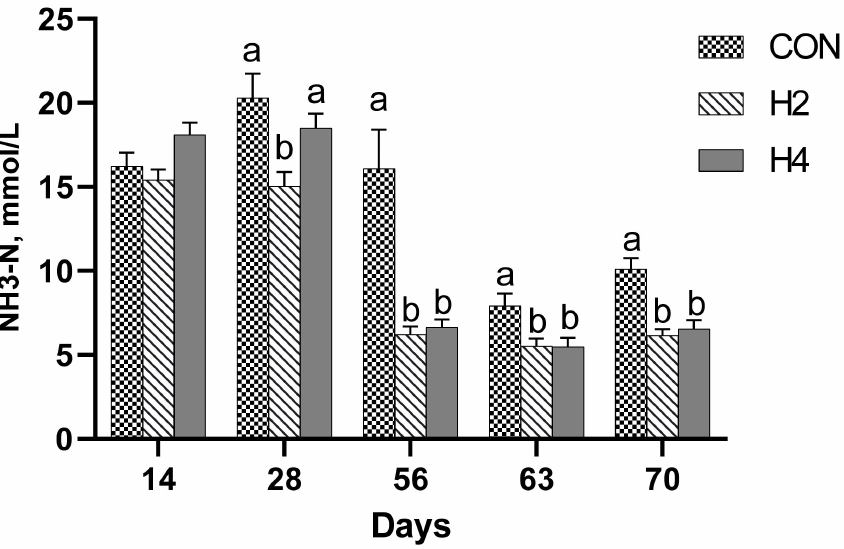
Figure 5. Ruminal NH 3 -N for Holstein female calves fed a basis diet without (CON: checkered bar; n = 14) or with hay inclusion from the second (H2; stripe bar; n = 14) or fourth (H4; gray bar; n = 14) week of age. Different letters within a time point indicate significant differences between treatments ( p < 0.05).